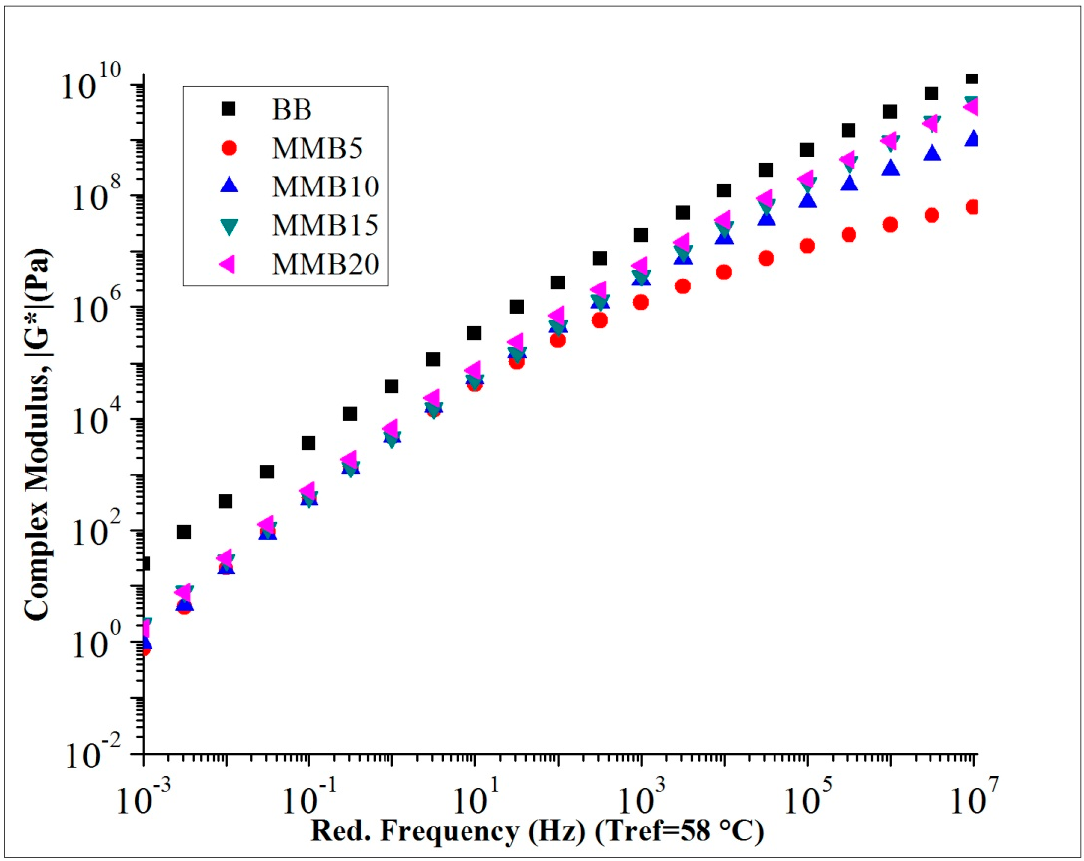
Figure 11. High-temperature complex shear modulus master curve (T ref = 58 ◦ C).